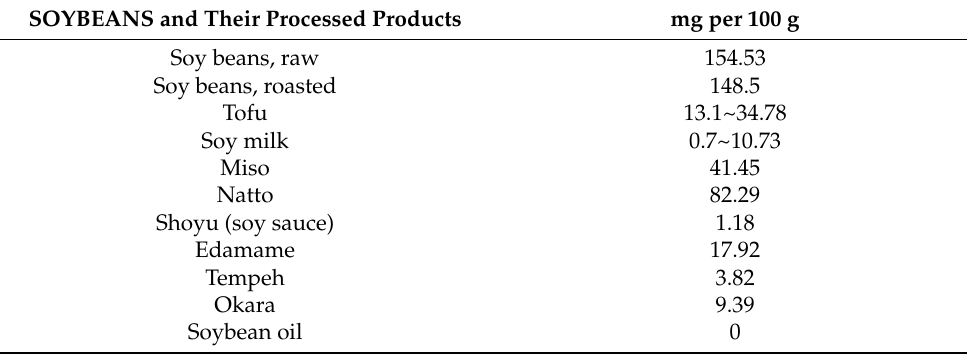
Table 2. Isoflavone content of soybean and processed soybean products. SOYBEANS and Their Processed